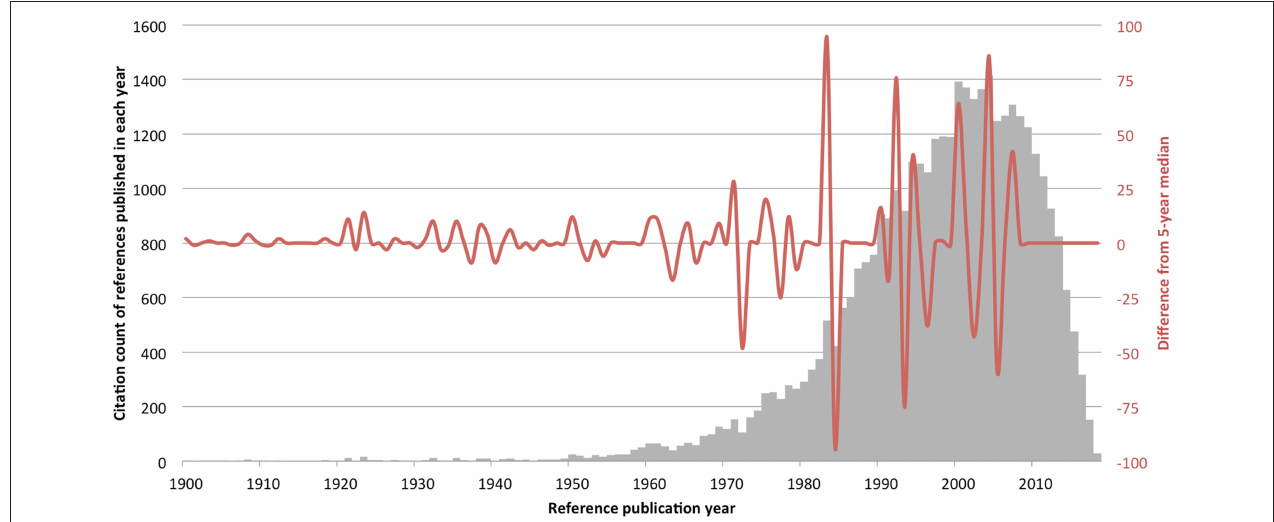
FIGURE 1 | Results from reference publication year spectroscopy (RPYS). The reference lists of the 958 psychology publications concerning visual analog scale were analyzed by CRExplorer. References were sorted by publication year (x-axis), and the citation counts received by each reference published in the same year were summated (gray, left y-axis). The spectrogram has plotted the difference in annual citation count from its 5 years median (red, right